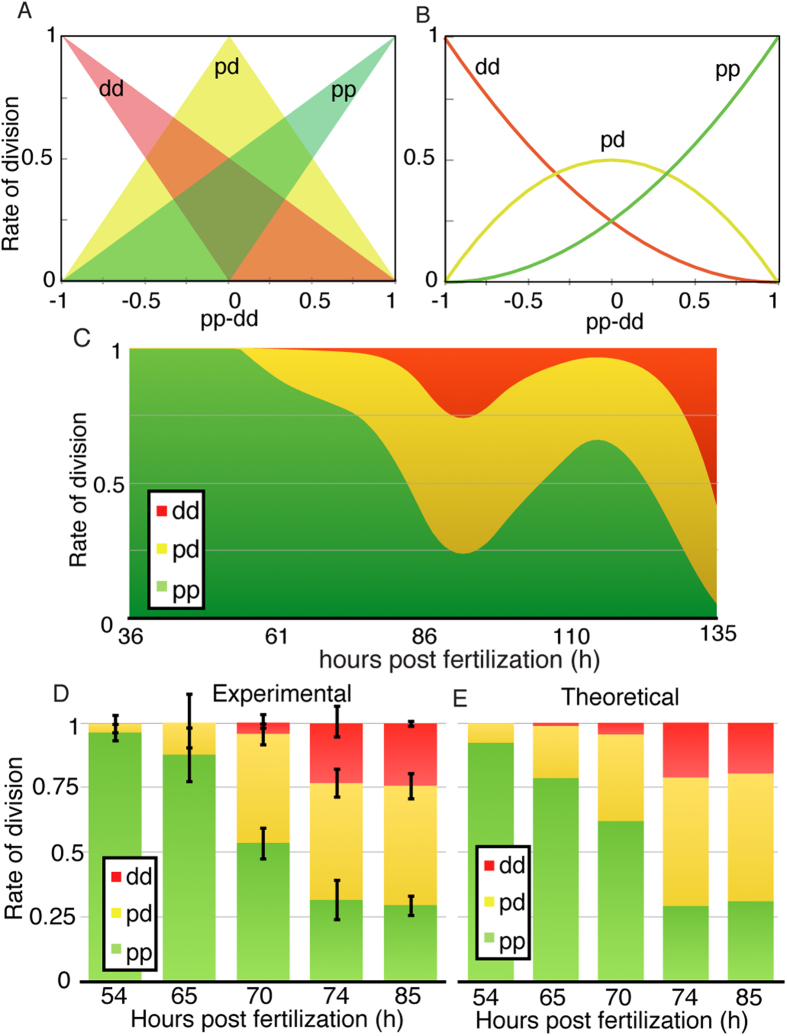
Experimental data for the division rates correlates with the binomial distribution hypothesis.(A) Possible ranges of values for each mode of division pp, pd and dd for each value of pp − dd. (B) Exact solution of the model equations for each mode of division when considering the binomial approach for the generation of each division mode. (C) Model predictions for each mode of division based on the experimental quantification. (D) Experimental3 and (E) theoretical values for each rate of division at the same times given by the binomial distribution hypothesis (statistical comparison can be found in Supp. Fig. 4).